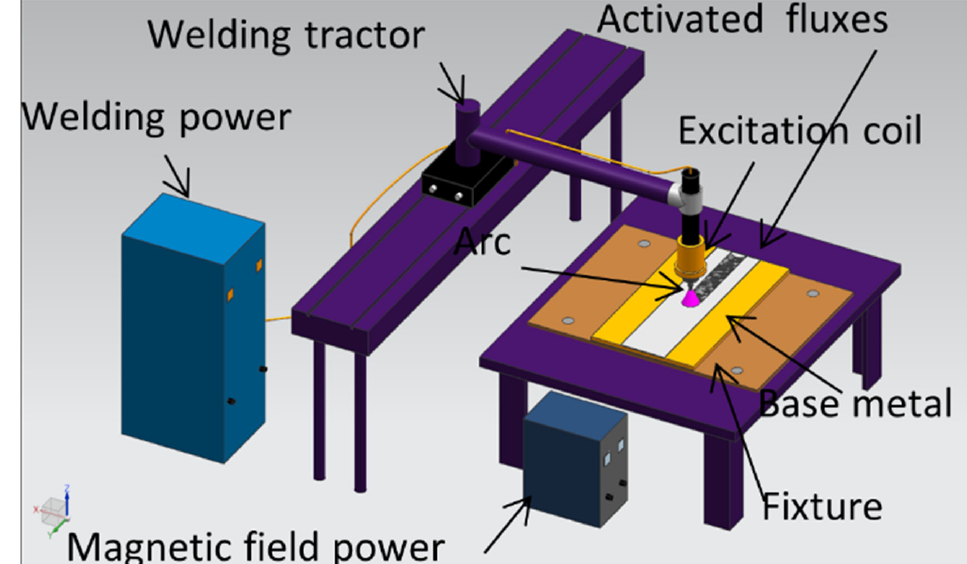
Figure 1. Schematic diagram of welding device. After welding, the specimens were cross-sectioned from the welded plates and fine polished for microstructure and mechanical properties of welded joints. The weld pene- tration and width were measured using body vision microscope. The microstructure was observed by scanning electron microscopy (Hitachi S-3400, Hitachi microscopes, Tokyo, Japan). XRD-700 was used to determine the phases formed in the weld metal. The grain size and orientation of welded joints were characterized by EBSD (ZEISS G300, ZEISS, Oberkochen, Germany). The length, width, and thickness directions of the specimens were defined as the rolling direction (RD), transverse direction (TD), and normal direction (ND), respectively, shown in Figure 2. The EBSD specimens were ground and polished first, and then mechanically polished until the surfaces were bright and without visible scratches under the optical microscope. Final electrolytic polishing was performed using the so- lution mixed with 10% perchloric acid and 90% alcohol. The temperature of electrolyte is controlled at − 30 ◦ C. The electrolytic voltage and time is 15 V and 120 s, respectively. Microhardness was determined with THVS-5 Vickers hardness tester under a dwell time of 15 s with a load of 500 g. The tensile tests were carried out using a universal testing machine under a velocity of 3